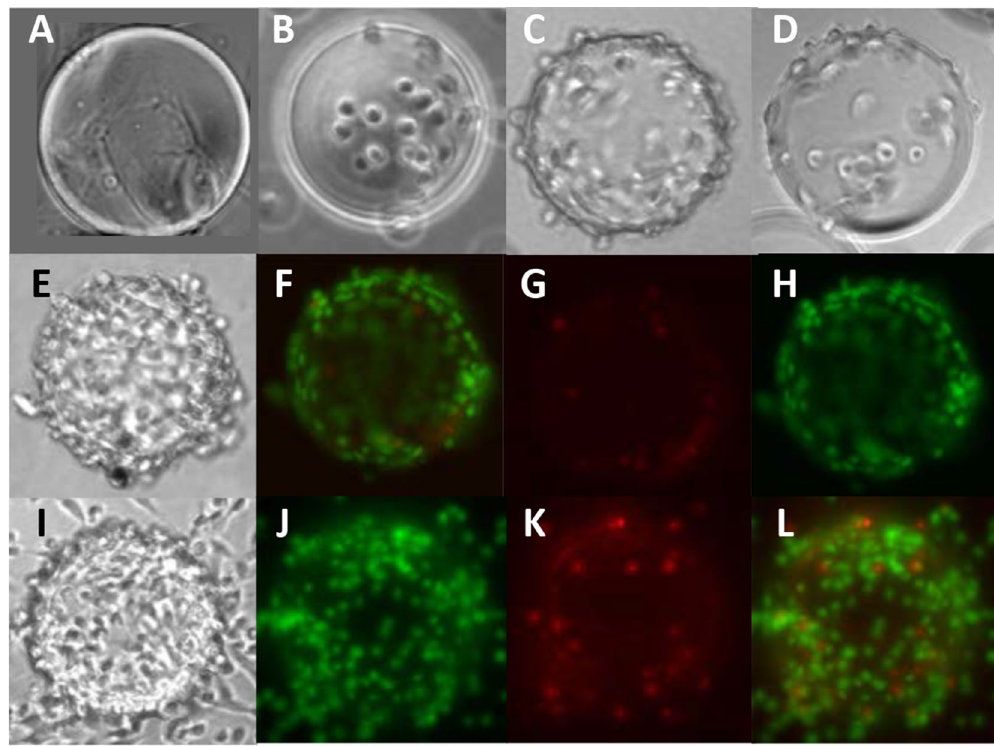
Figure 4. Images of RPTEC/TERT1 in cell spinpods. RPTEC/TERT1 on microcarrier beads were cultured in rotating or static cell spinpods for 48 h after which PI, which is taken up by dead cells, and CyQUANT, a FITC- based reagent that stains all cells, were injected into the cell spinpods to stain the cells in situ. Panel ( a ) shows a 175 micron Cytodex-3 microcarrier bead without cells. Panel ( b ) is a bright field image of a cell spinpods on day 0, immediately after loading renal cells that have incubated 1 h with carrier beads. Panels ( c ) and ( d ) are bright field images of cell spinpods on day 1, rotating and static, respectively. Panels ( e ) through ( h ) are from a rotating cell spinpod and panels ( i ) through ( l ) are from a static cell spinpod on day 2. Panels ( e ) and ( i ) are the bright field images. Panels ( f ) and ( j ) are the FITC images. Panels ( g ) and ( k ) are the PI images. Panels ( h ) and ( l ) are the fused FITC and PI images. Magnification 100×. Photographs were taken by author